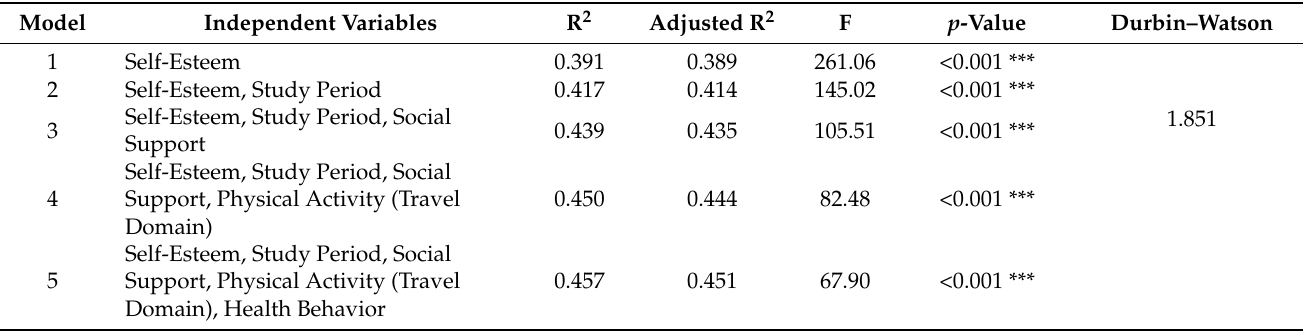
Table 3. Stepwise multiple regression analysis model with stress level as the dependent variable.